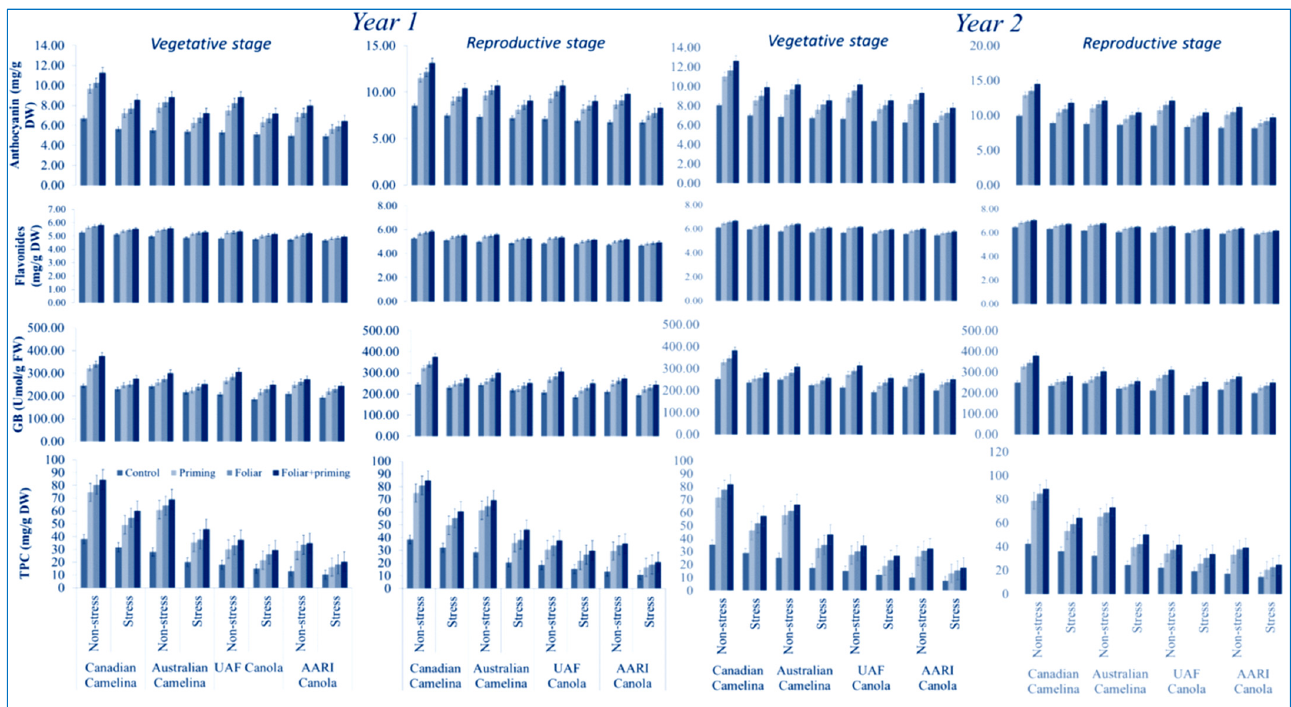
Table 1. Molecules 2019 , 24 , x FOR PEER REVIEW